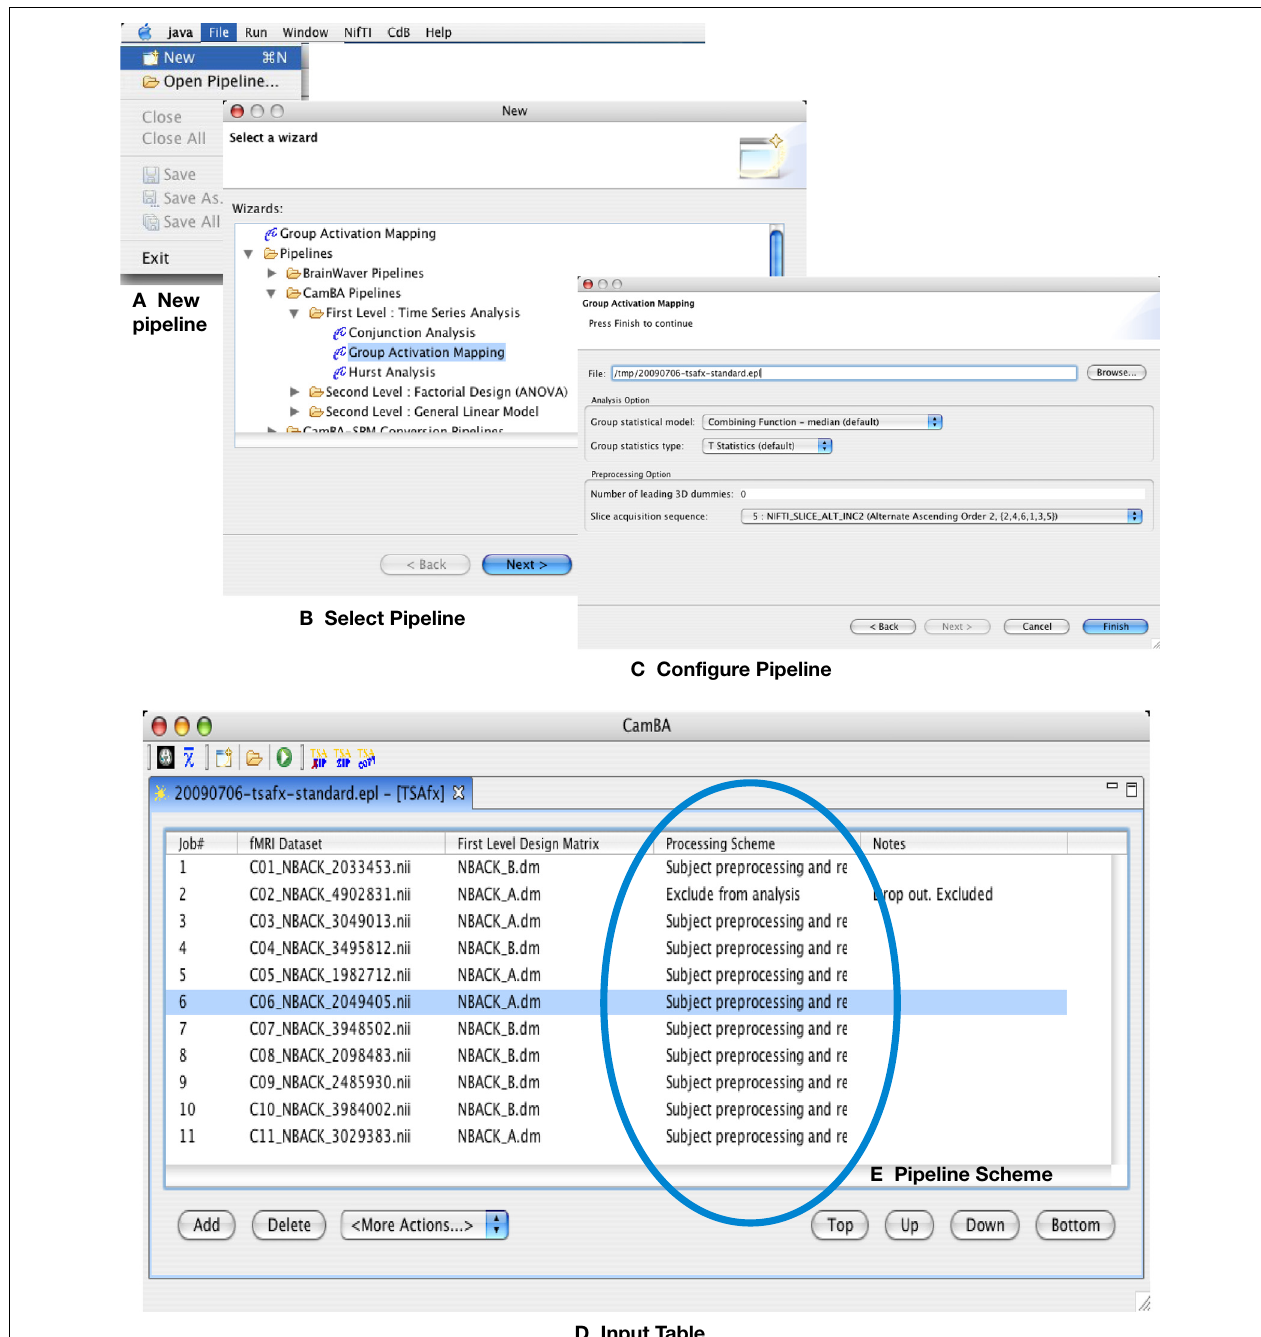
FIGURE 1 | Steps in operation by consumers to select, create and modify workfl ows. See text for